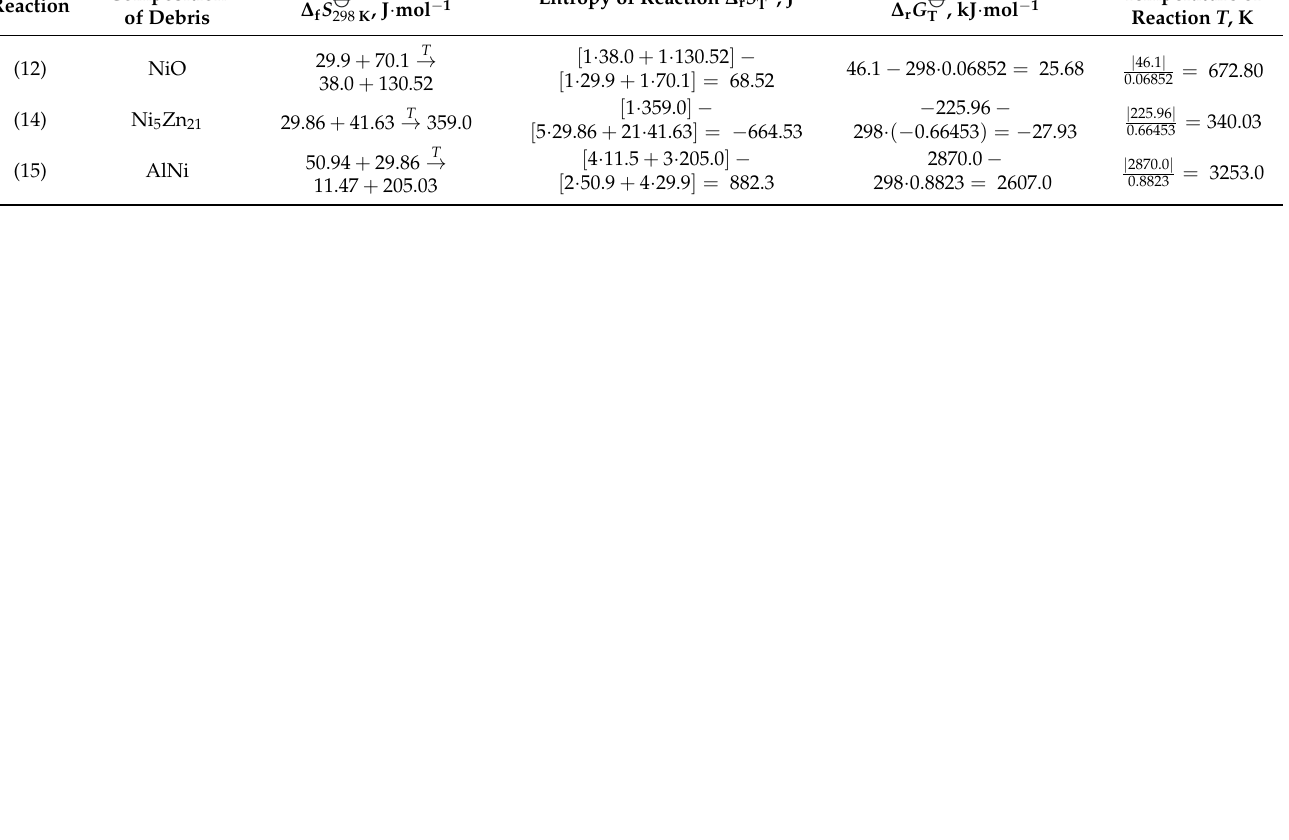
above zero. It means that the reaction under normal conditions can only pass in the re-